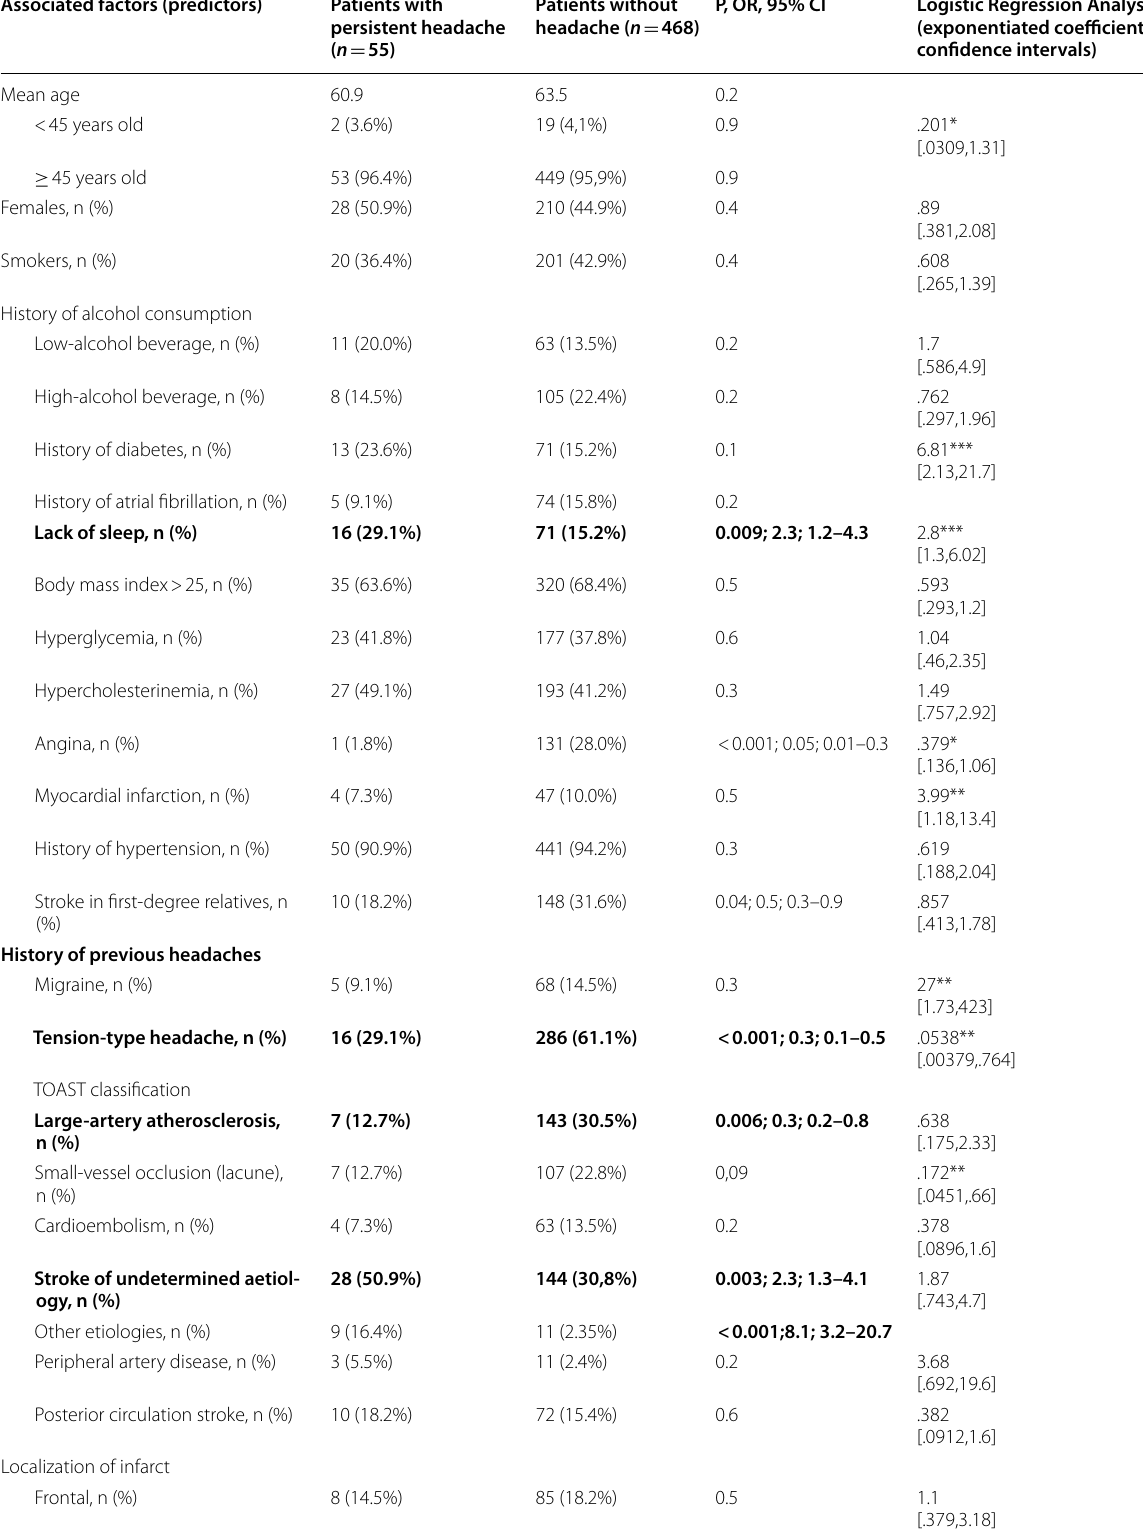
Table 4 Factors associated with persistent headaches after first-ever ischemic stroke Associated factors (predictors) Patients with